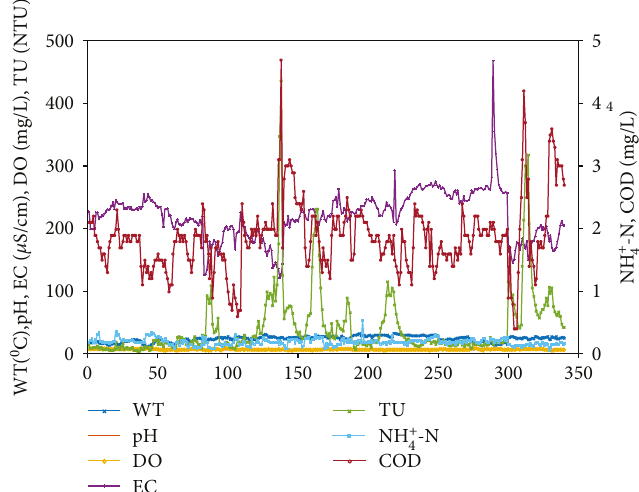
Figure 3: Variations of water quality